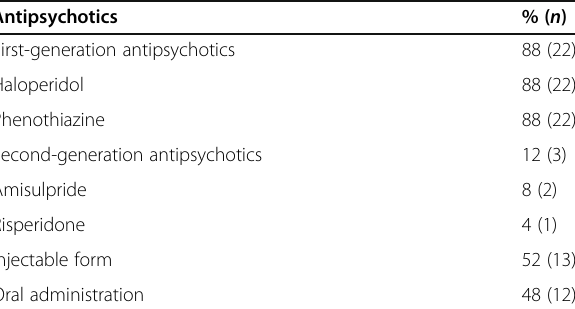
Table 5 Antipsychotics causatives of NMS